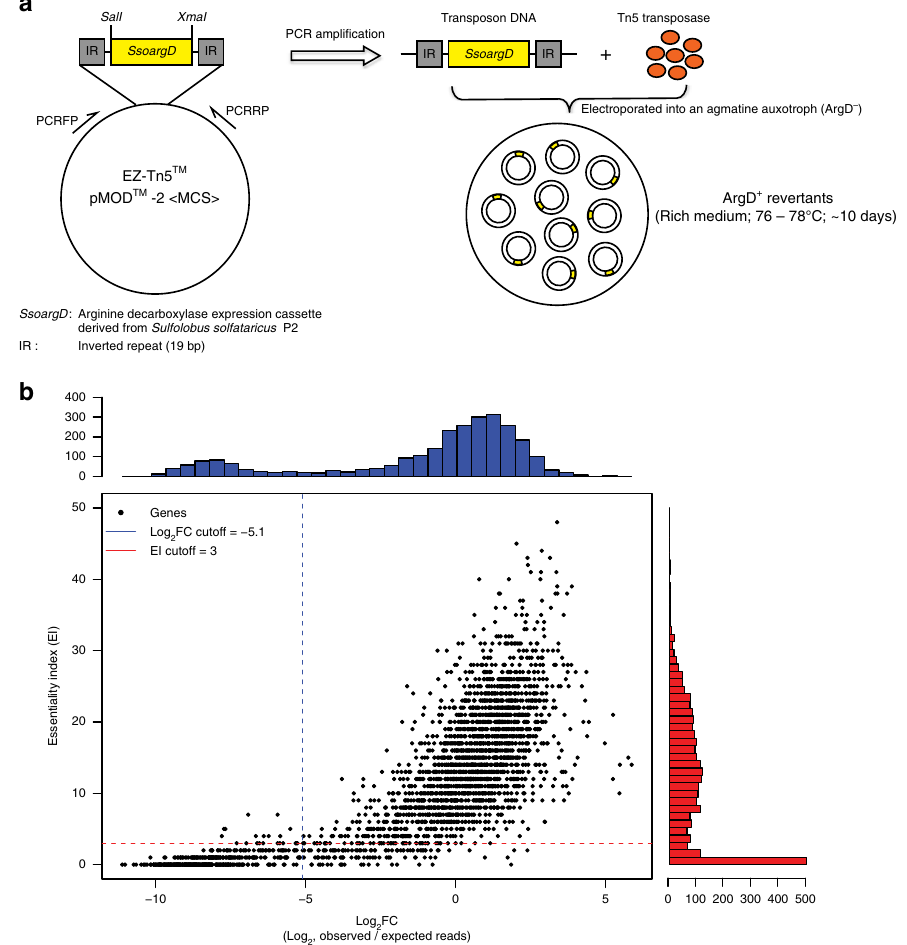
Fig. 1 De fi ning the essential genes in S. islandicus M.16.4. a Schematic overview of the genome-wide transposon mutagenesis strategy. b Evaluation of gene essentiality by two computational programs: ESSENTIALS 23 and Tn-Seq-Explorer 24 . Points indicate individual genes plotted according to the scores returned by each program. Histograms indicate the number of genes of a particular score, and the dotted lines indicate the recommended cutoffs returned by each program as the local minimum between the essential and non-essential score distributions. Essential genes meet both criteria (lower-left quadrant). The protein-coding genes that only met the ESSENTIALS or Tn-Seq-Explorer criteria were deemed as “ unassigned candidates ” leaving the rest as likely non-essential to S. islandicus M.16.4 growth under these conditions. A complete list of the log 2 FC and EI for the S. islandicus M.16.4 genes from